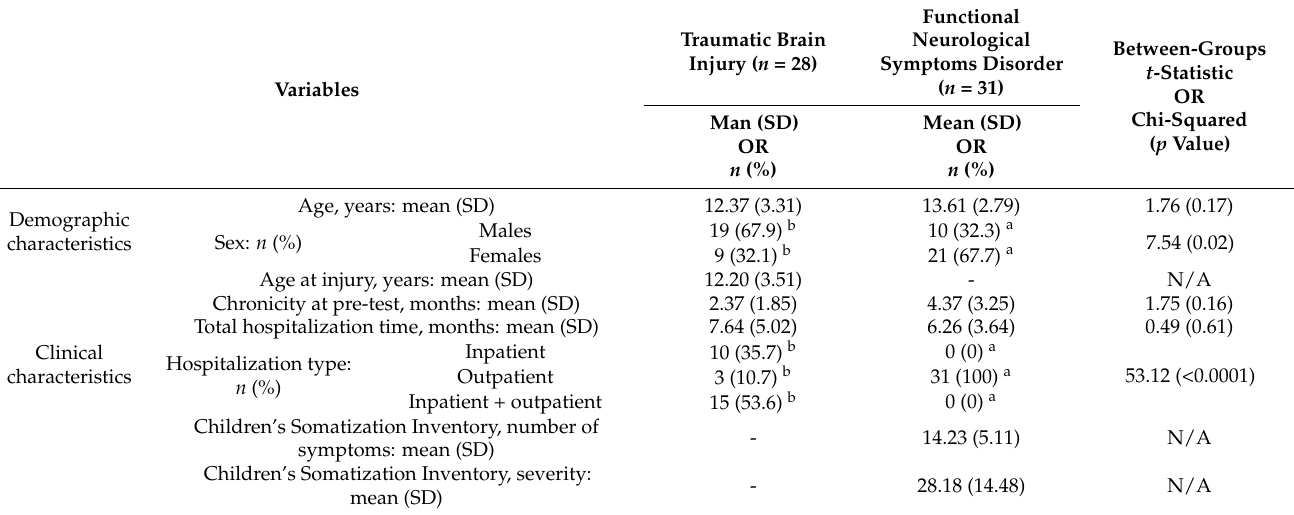
Table 1. Demographic and clinical characteristics of study